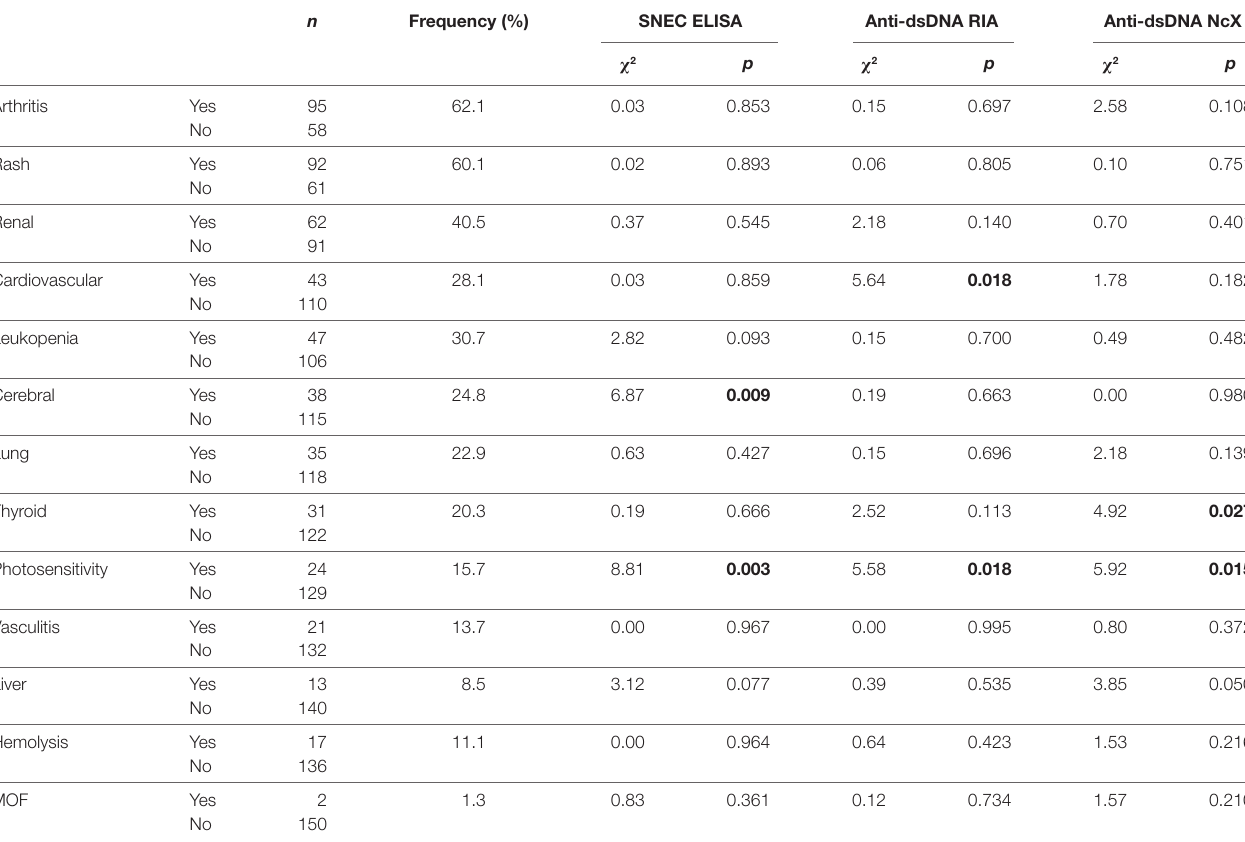
TaBle 3 | Frequencies of organ affection by autoantibody test and statistics from contingency tables.